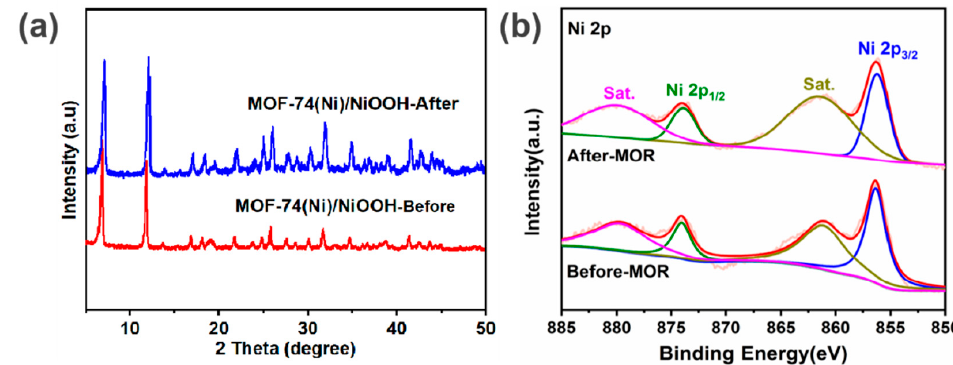
Figure 5. ( a ) PXRD pattern of MOF-74(Ni)/NiOOH catalysts before and after the MOR process. ( b ) High-resolution XPS spectra of Ni2p of MOF-74(Ni)/NiOOH catalyst before and after MOR.